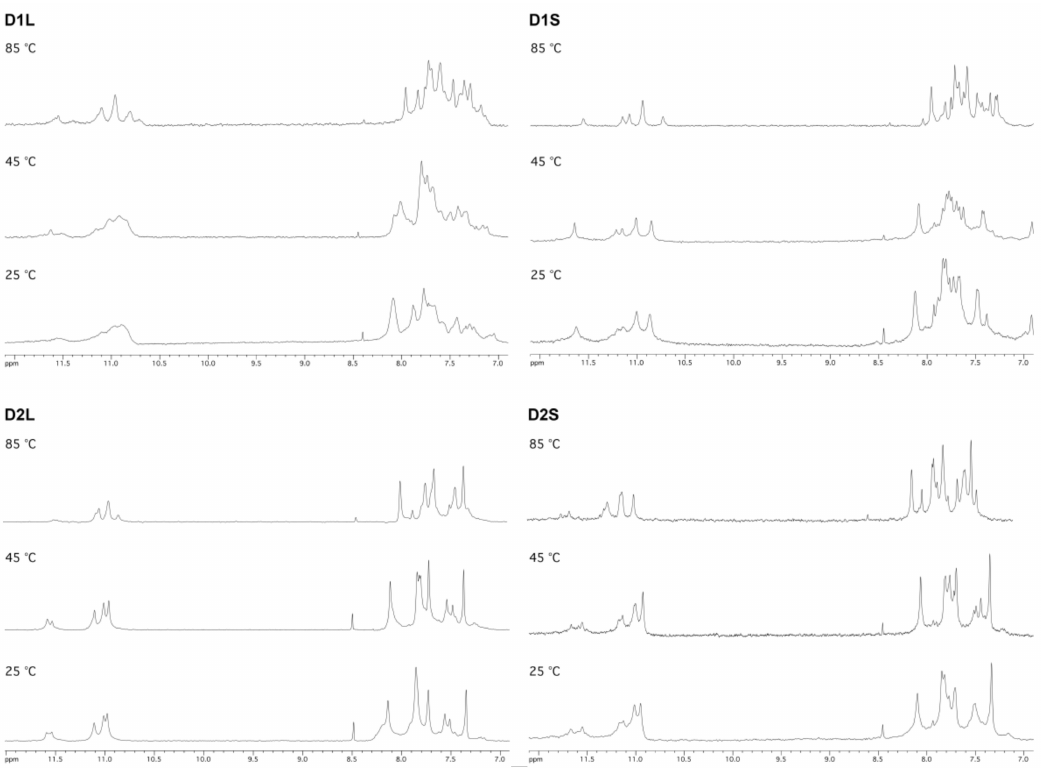
Figure 5. Downfield region of the water-suppressed NMR spectra of D1L,S and D2L,S annealed in 100 mM K + buffer and recorded at 25, 45 and 85 ◦